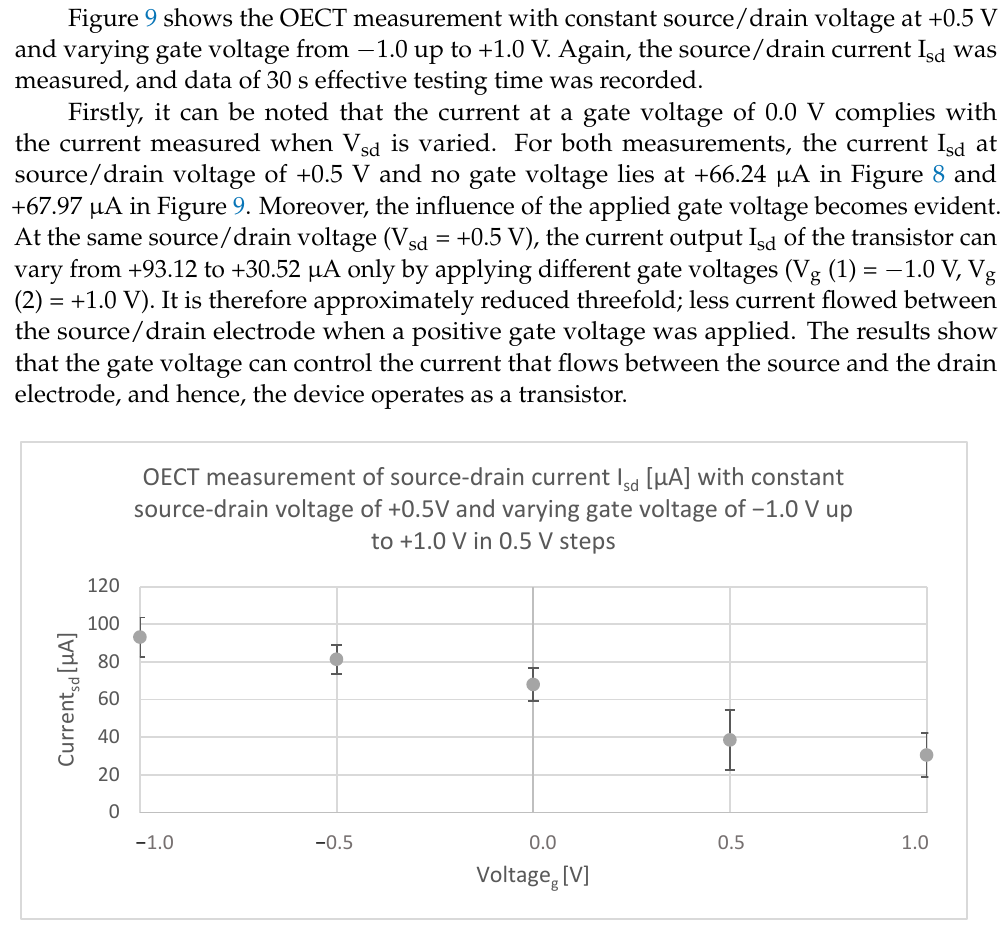
Figure 9. OECT measurement showing that gate voltage (V g ) controls the current that flows between the source and drain electrode (I sd ). When V g is increased from − 1.0 V to +1.0 V, the drain current drops.